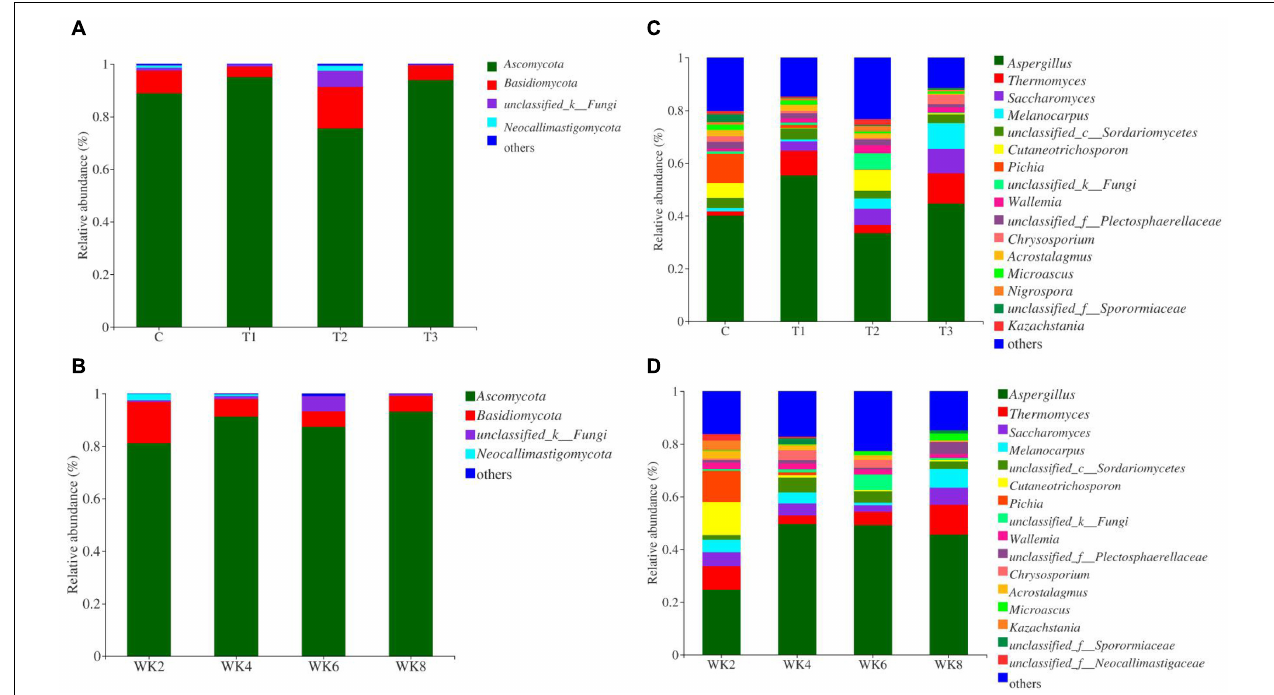
FIGURE 4 | Composition of the fecal microbial community. Panels (A,B) show the composition of the microbial community in the four groups (C, T1, T2, and T3) with respect to the phyla and genera of fungi. Panels (C,D) show the compositions at four time points during the study (WK 2, 4, 6, and 8).